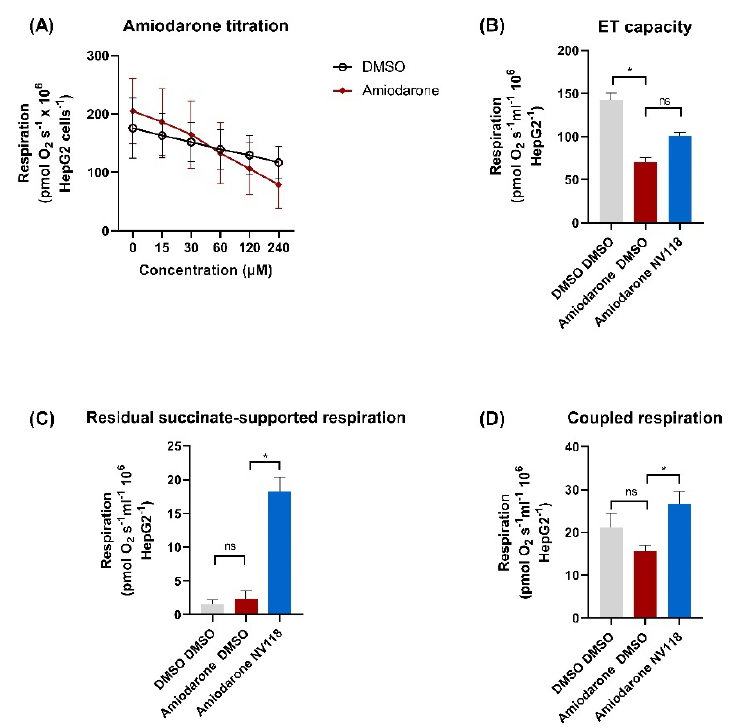
Figure 6. Effects of NV118 on amiodarone-induced mitochondrial dysfunction in human HepG2 cells. ( A ) Respiration of HepG2 cells was measured after mild uncoupling with FCCP (4 µM). The dose-dependent effect of amiodarone (red rhombus) was measured by titrating increasing concentrations of amiodarone or vehicle (DMSO, open black circle). Non-mitochondrial respiration was evaluated by the inhibition of complex I with rotenone (2 µM) and that of complex III with antimycin A (1 µ g/mL). ( B – D ) NV118 effects (blue) on amiodarone-treated HepG2 cells were assessed as compared to its vehicle (DMSO, red). As negative control of the experiment HepG2 were exposed only to DMSO (grey). Data were expressed as mean ± SEM. Two-way ANOVA and one-way ANOVA with Bonferroni post hoc test were performed on the antimycin-corrected data. DMSO: dimethyl sulfoxide. ET: electron tran sfer. ns= not significant. * p < 0.05 vs. DMSO. n = 3– 4 .